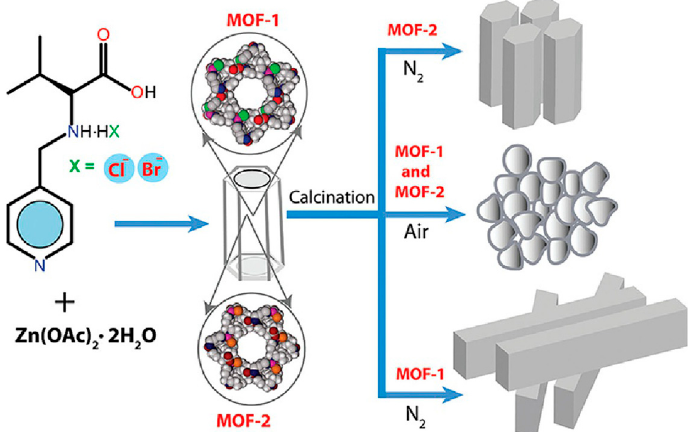
Figure 5. Synthetic routes to different ZnO nanostructures through one-step thermolysis of porous homochiral MOFs under N 2 or air. Reproduced with permission from [92].